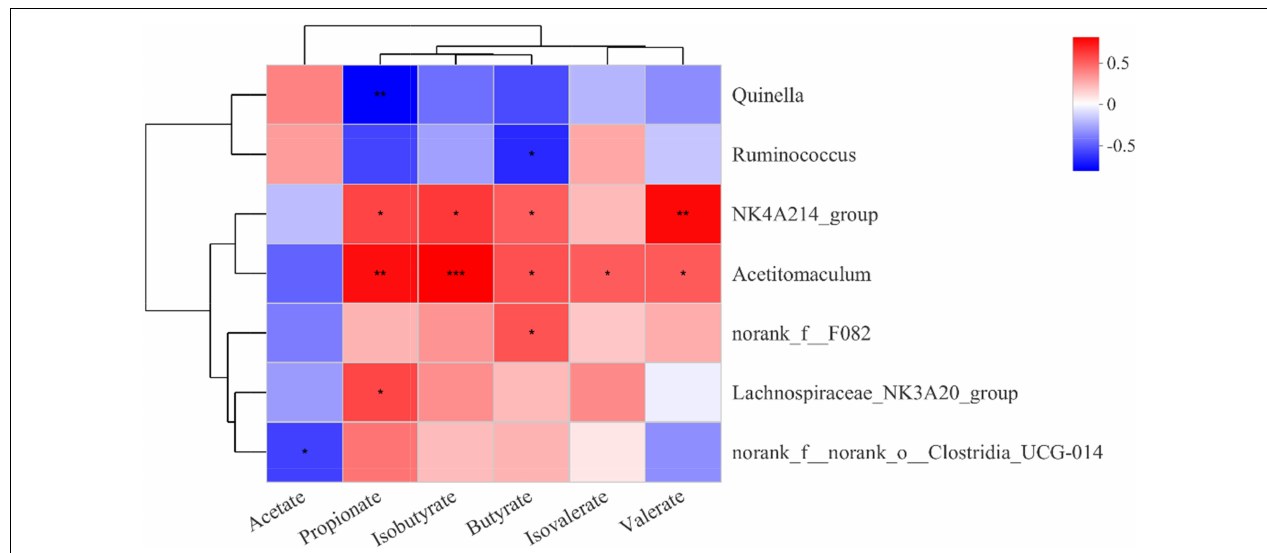
FIGURE 3 | Correlation of rumen bacteria with rumen fermentation parameters. Each row in the figure represents a genus, each column represents a metabolite, and each cell represents a Pearson correlation coefficient between a genus and a metabolite. Red denotes positive correlation and blue denotes negative correlation; *0.01 < P ≤ 0.05; **0.001 < P ≤ 0.01; *** P ≤